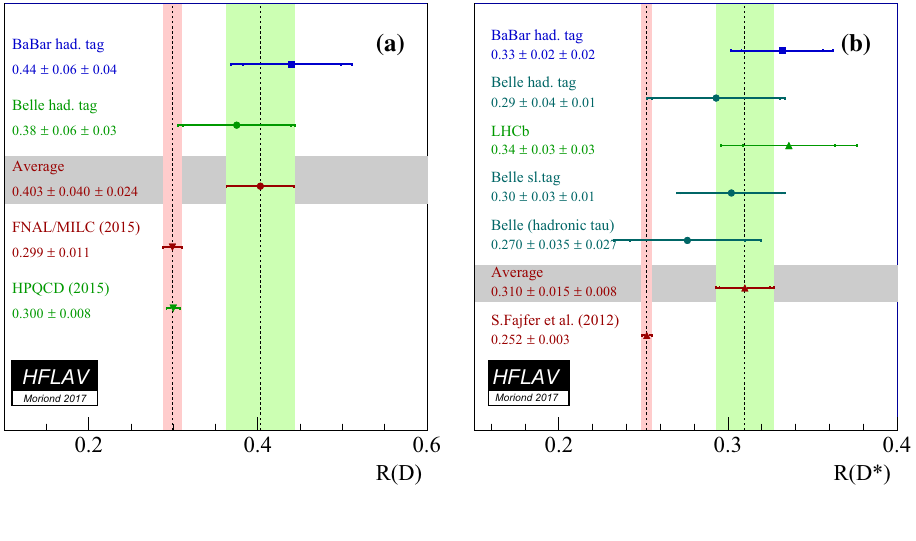
Fig. 67 a Measurement of R ( D ) and b R ( D ∗ ) . The average is the projection of the average obtained from the combined